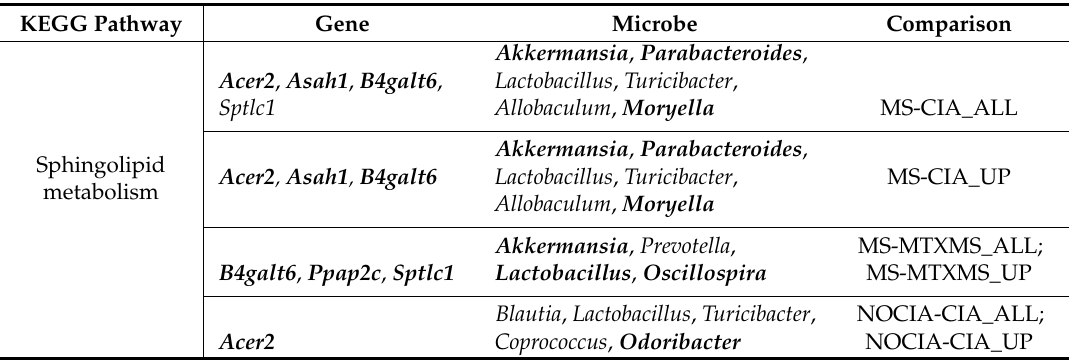
Table 2. Sphingolipid metabolism pathway enriched by PBMC transcripts and microbiome KOs, excerpt from Data S5. KEGG Pathway Gene Microbe